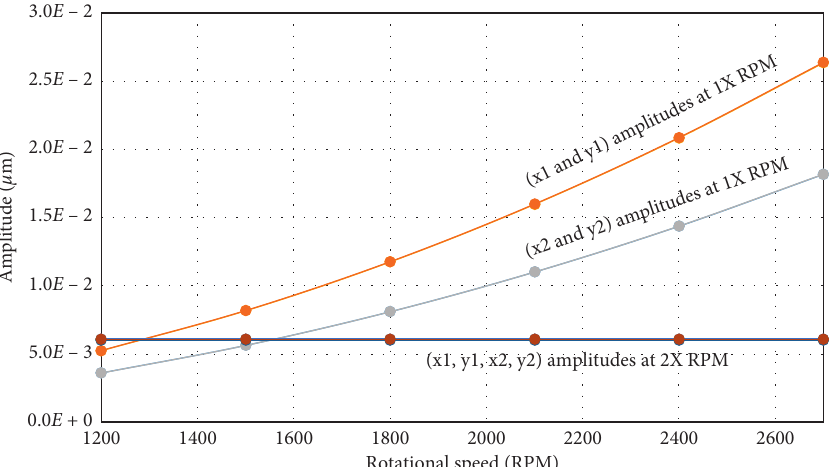
Figure 21: Effects of different rotational speeds on the vibration response of the system with imbalance and parallel misalignment.